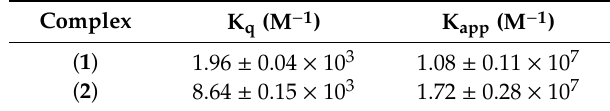
Figure 4. Fluorescence quenching spectra of ethidium bromide-DNA (EB-DNA), ( a ) complex ( 1 ), and ( b ) complex ( 2 ), [DNA] = 5 µM, [EB] = 5 µM and compounds (5–90 µM) for complex ( 1 ) and (5–50 µM) for complex ( 2 ). Table 1. Interaction study of complexes ( 1 ) and ( 2 ) with